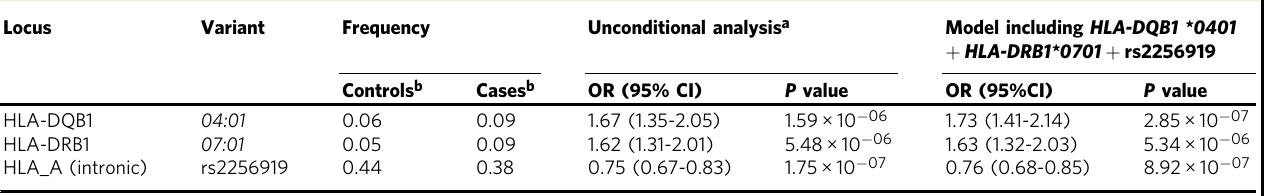
Table 3 Top associations of the HLA alleles with adenocarcinoma of Asian ancestry